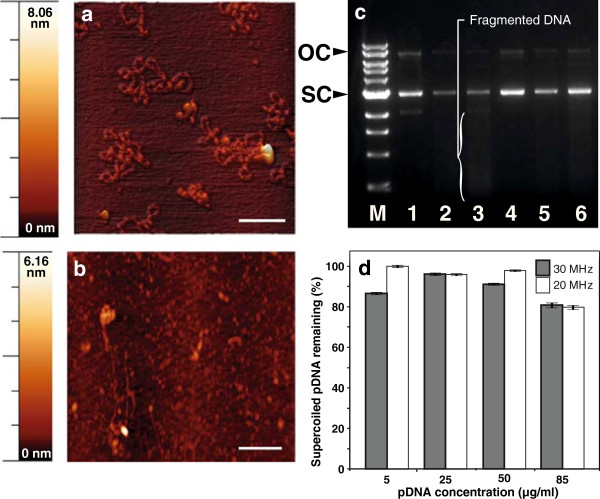
SAW nebulization preserves the integrity of pDNA. Atomic force microscopy (a, b) and ethidium bromide agarose gel electrophoresis (c) of pVR1020–PyMSP4/5 (a) before and (b) after nebulization. Lane M: 1 kbp DNA ladder; control lanes 1 and 4, recovered pDNA post-30 MHz lanes 2 and 5, and post-20 MHz SAW nebulization lanes 3 and 6 are each at 85 and 50 μg/ml concentrations, respectively. The proportion of (d) supercoiled (SC), open circular (OC) and fragmented pDNA quantifies the damage (n=3). Bars represent the mean of trplicate samples with error bars indicating the standard error of the mean. Data is representative of three independent experiments.